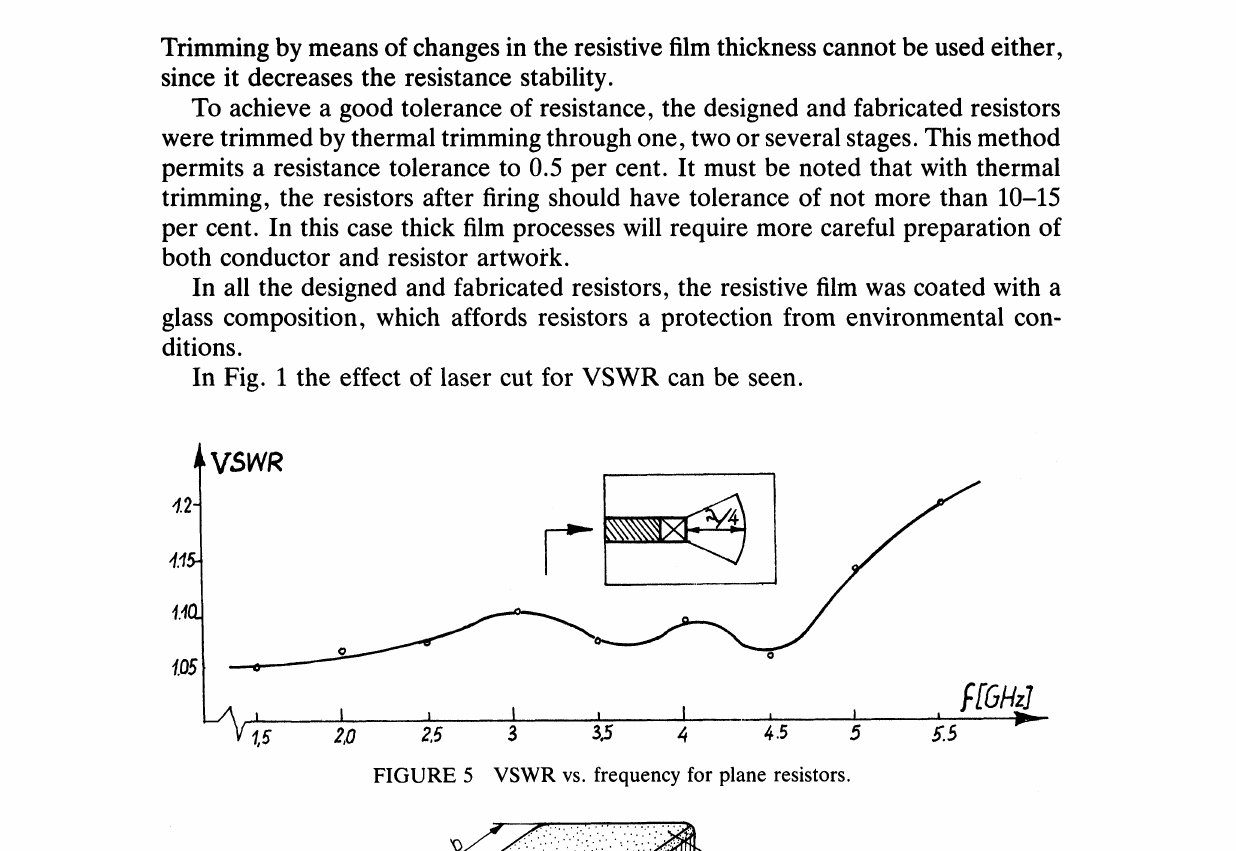
FIGURE 6 Spatial resistor configuration.